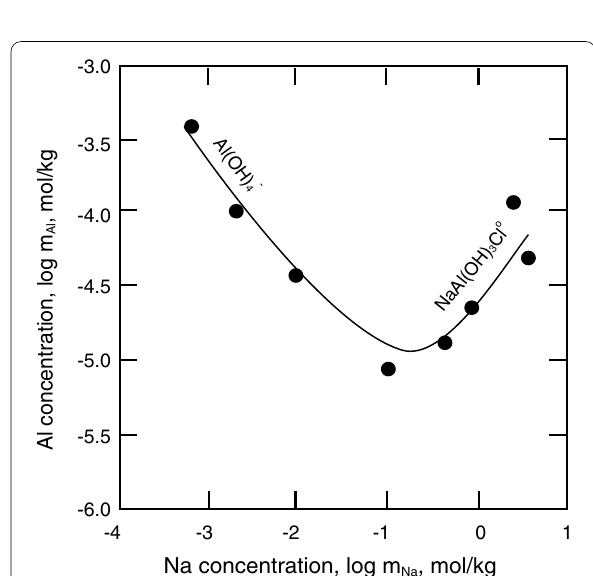
Fig. 23 Al speciation in H 2 O–NaCl fluid n as a function of Al and Na concentration in the system albite–aragonite–quartz–H 2 O–NaCl at 400 °C and 50 MPa in slightly acidic solution with pH Modified from Tagirov et al.